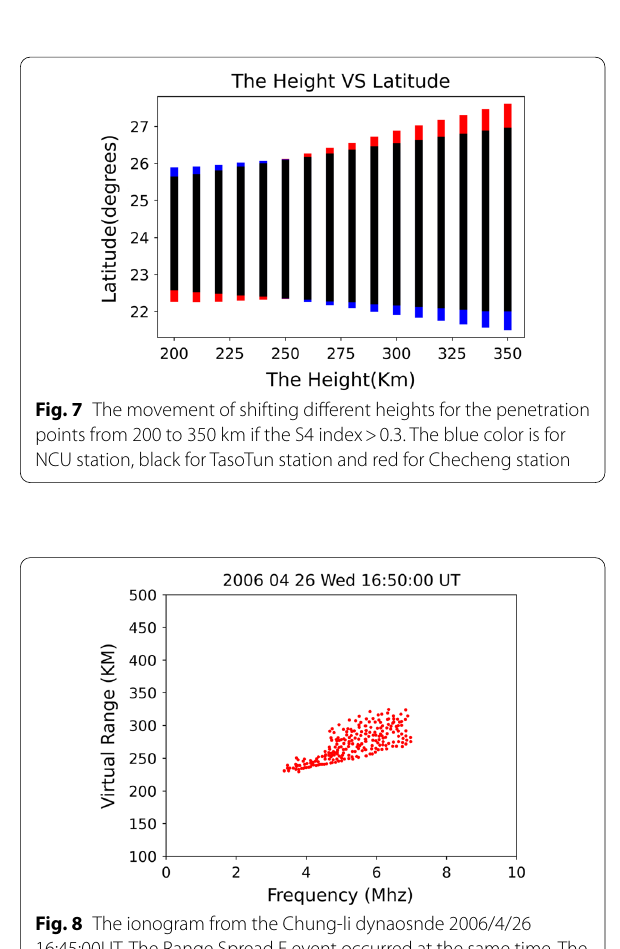
Figs. 5, 6 and 7, we may change the height of penetration points from 350 to 200 km to check the height of scintil- lation region, based on the results of the project method.